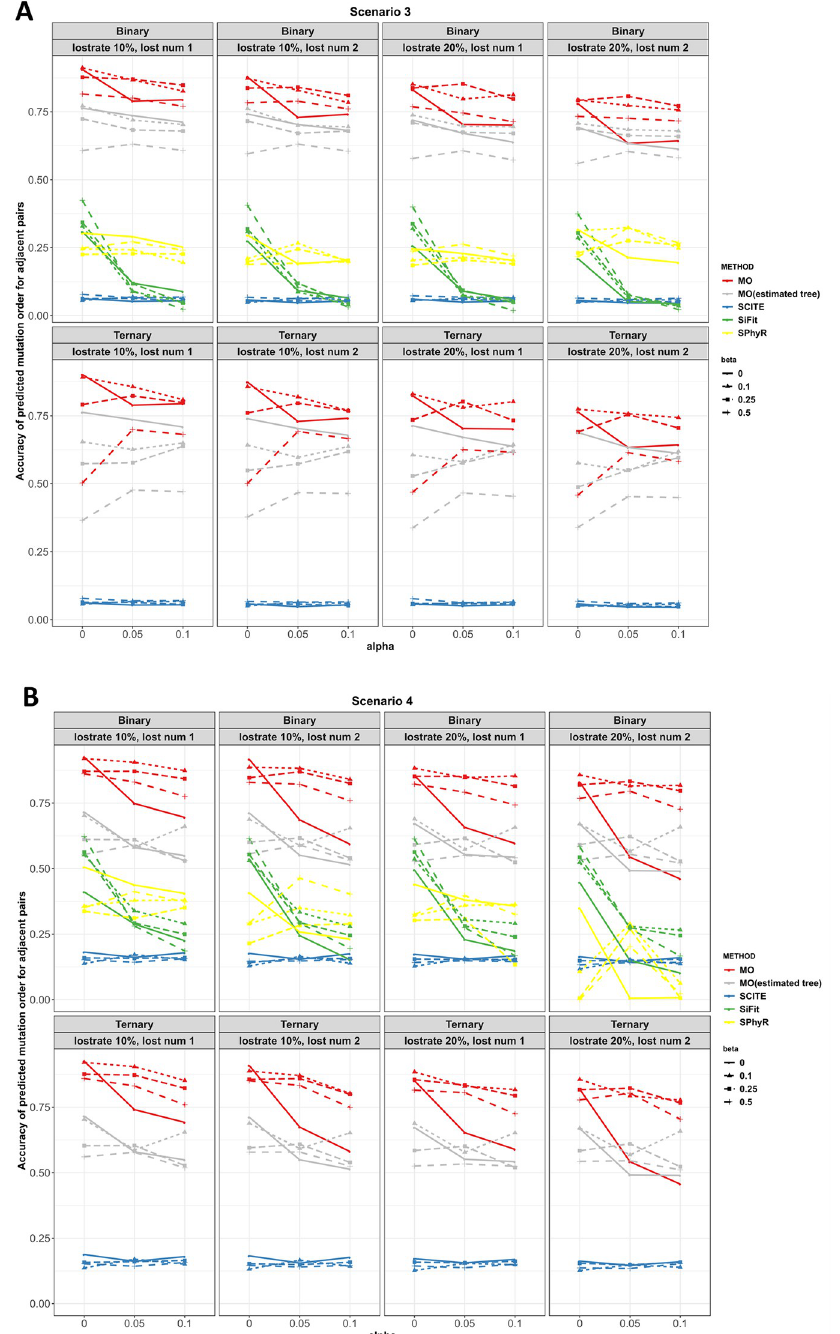
Fig 5. Adjacent order accuracy in scenarios 3 and 4 for MO, SCITE, SiFit and SPhyR when there are 20 mutations. Each panel includes the results from the specific type of genotype and lost mutations. In each panel, red, gray, blue, green and yellow colors correspond to MO with the true tree, MO with the estimated tree, SCITE, SiFit and SPhyR, respectively. Each plotting symbol on the line represents a different β . The x-axis is the probability of an error, α , and the y-axis is adjacent order